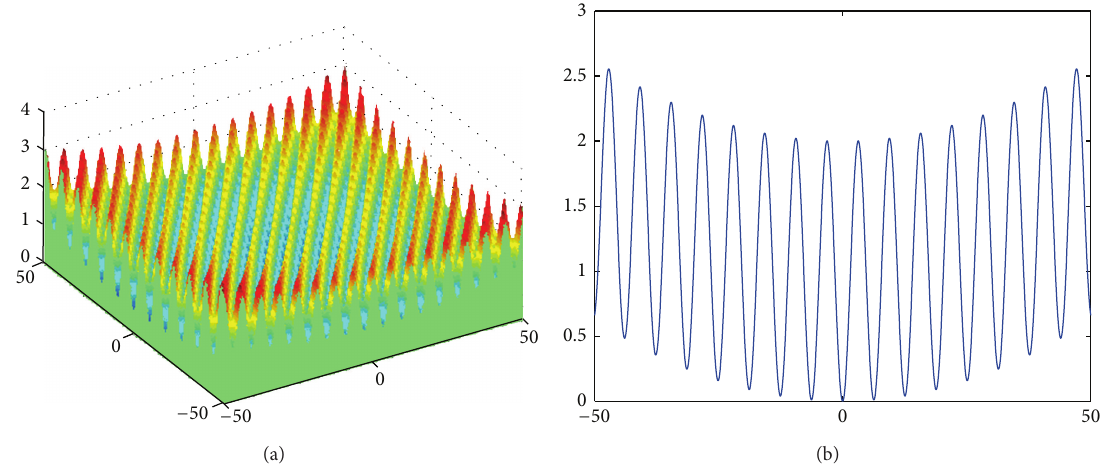
Figure 3: The Griewank function: (a) 𝑛 = 2 , (b) 𝑛 = 1 .